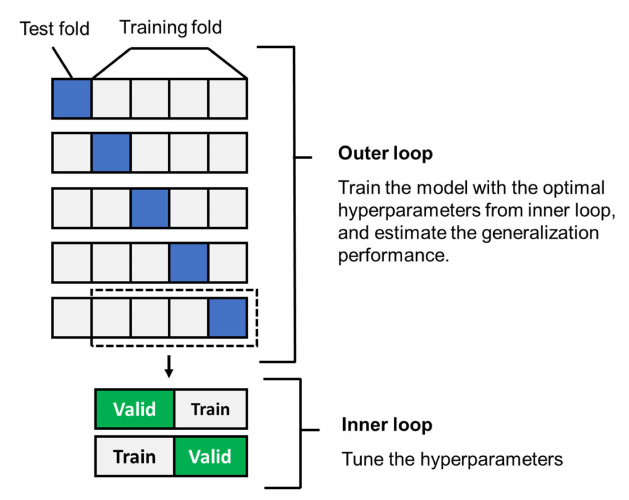
Figure 11. Nested cross-validation.